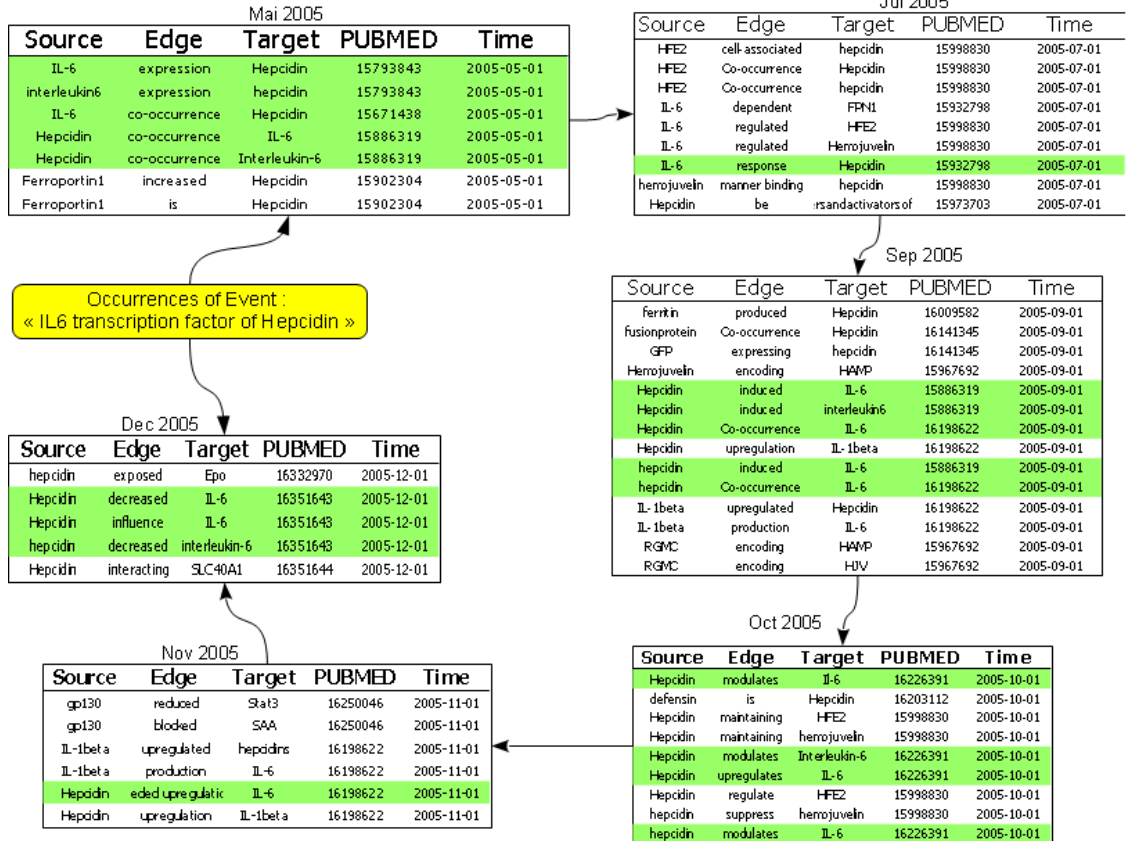
Figure 3. Background events relating hepcidin and interleukin-6 extracted at different